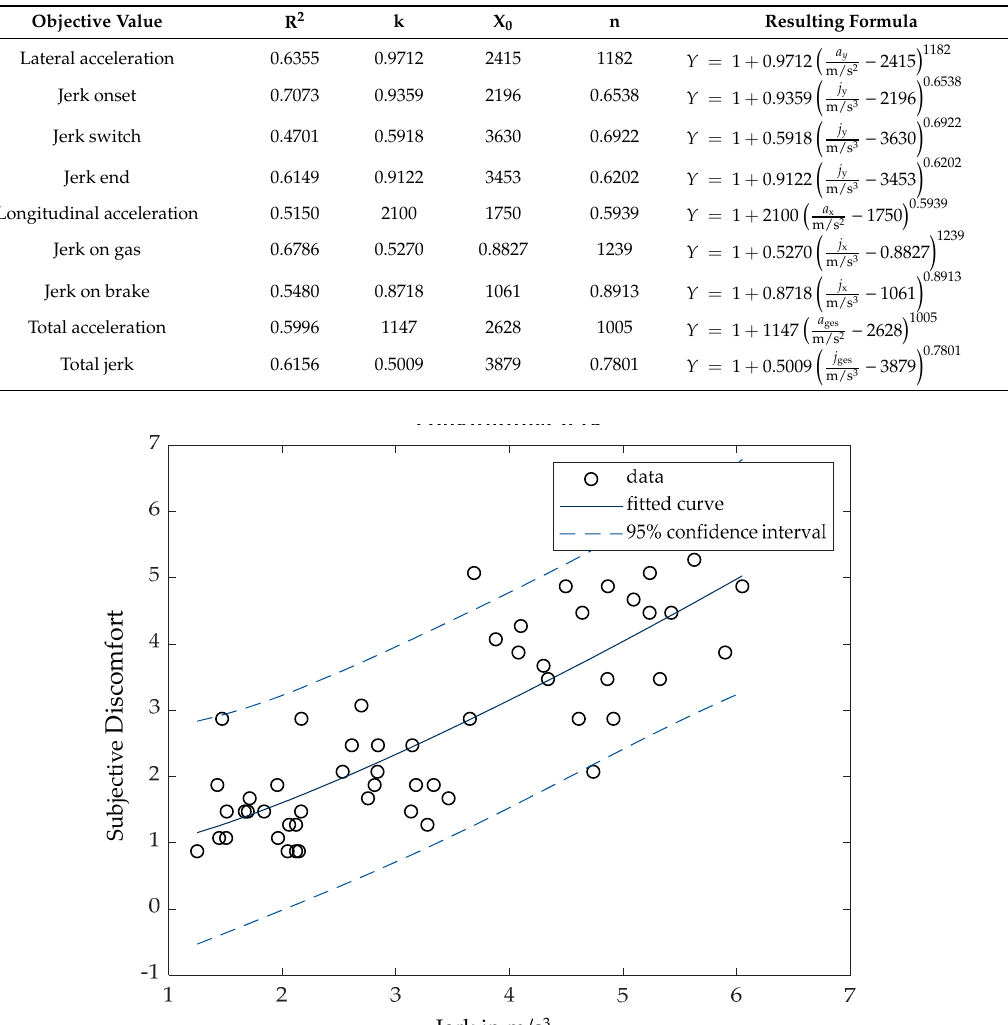
Table 3. Results from the regression analysis for all objective values in Maneuver A.